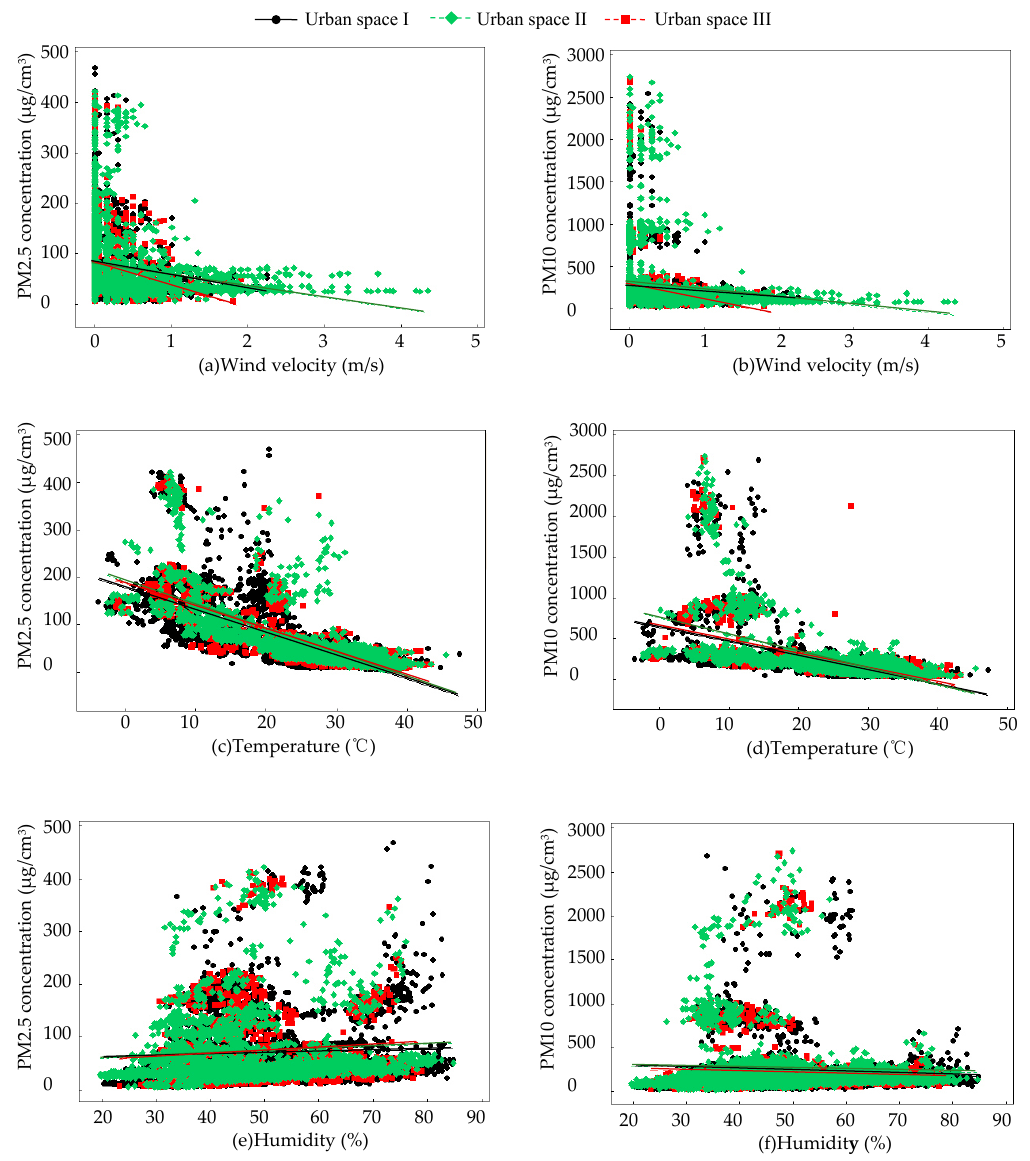
Figure 4. The relationship between meteorological factors and PM concentration. ( a ) The relationship between wind velocity and PM2.5 concentration; ( b ) the relationship between wind velocity and PM10 concentration; ( c ) the relationship between temperature and PM2.5 concentration; ( d ) the relationship between temperature and PM10 concentration; ( e ) the relationship between humidity and PM2.5 concentration; ( f ) the relationship between humidity and PM10 concentration.